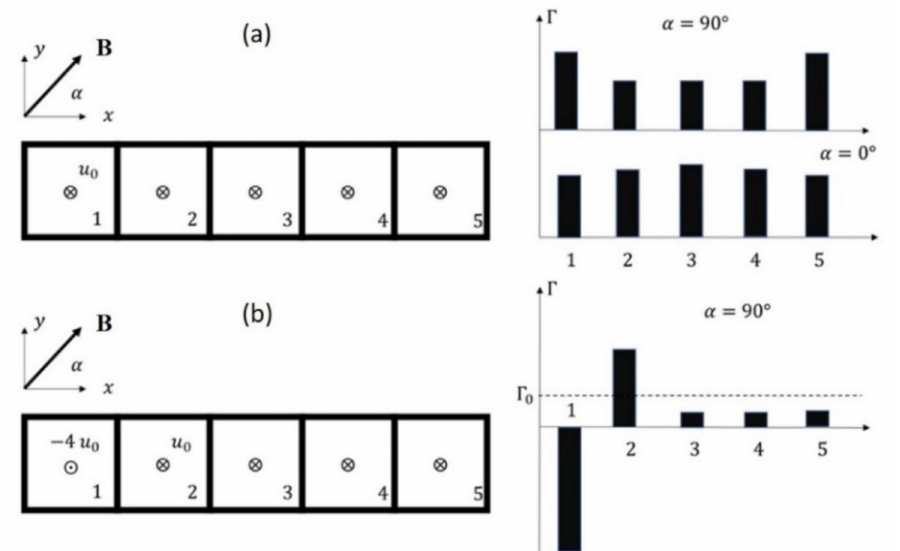
Figure 9. Qualitative representation of flow rate imbalance in parallel ducts due to electromagnetic coupling ( Ha = 10,000). ( a ) Coupling between channels with equal mean velocity through Hartmann wall ( α = 0 ◦ ) and side walls ( α = 90 ◦ ). ( b ) Coupling between channels with large difference in mean velocity and α = 90 ◦ . Channel no. 1 collects and returns all the flow rate incoming from no. 2 to no. 5 and Γ 0 represents the mean flux in ducts 2–5 assuming uniform flow